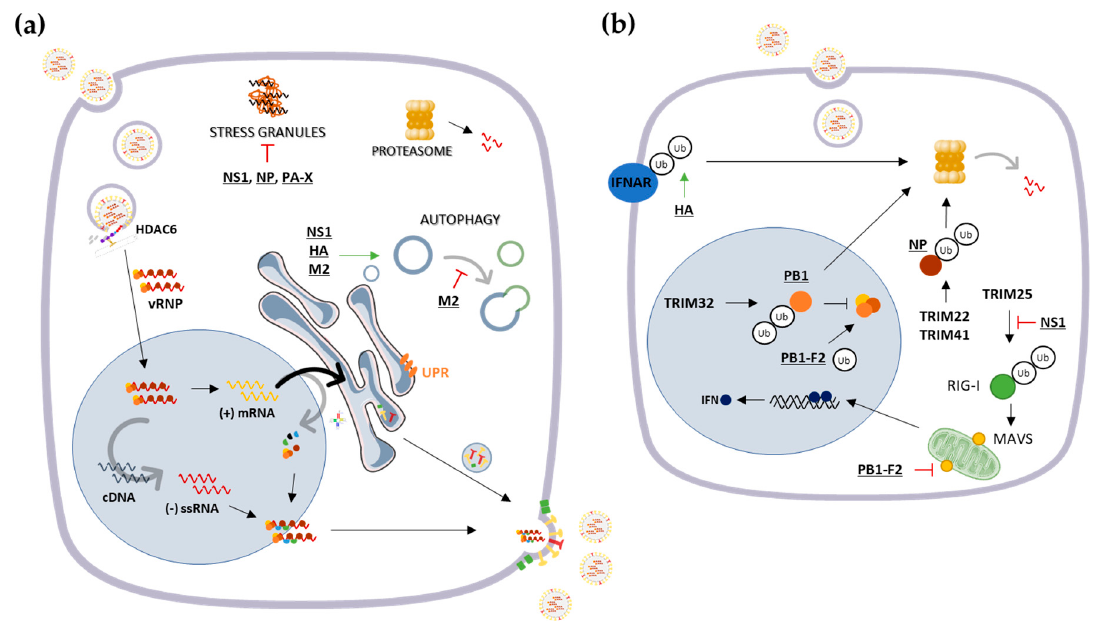
Figure 3. Schematic representation of cellular proteostasis mechanisms and its interplay with IAV proteins during infection. During its life cycle, the virus can interfere with several cellular proteostasis-related mechanisms, namely by ( a ) inhibiting stress granule formation or taking advantage of autophagosome formation, as well as by ( b ) manipulating ubiquitin-proteasome system (UPS)-related proteins to efficiently replicate. Viral proteins are represented underlined.